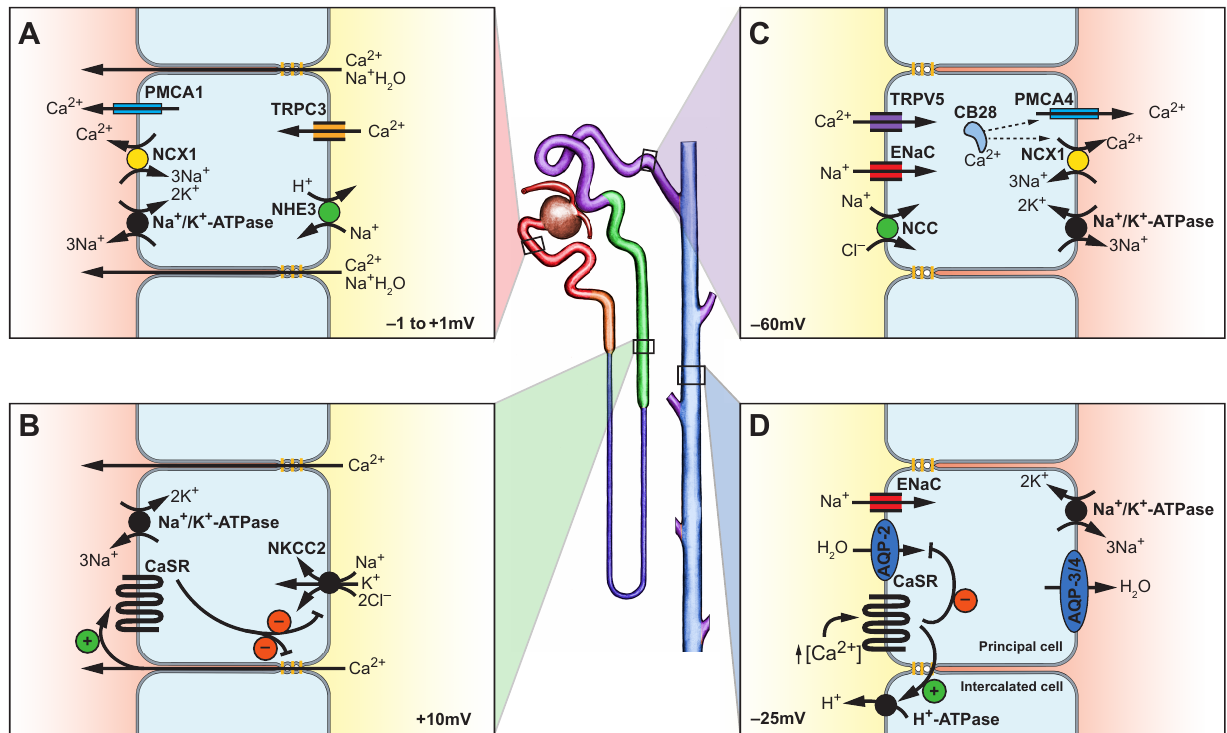
Figure 2. A schematic drawing of the renal tubular system. The glomerulus (brown) produces a primary urine that flows into the proximal convoluted tubule (red). Then, it reaches the proximal straight tubule before ending up in the loop of Henle, which is composed of a thin (dark blue) and a thick (green) part. The latter drains the urine into the distal convoluted tubule (purple) before reaching the collecting duct (light blue) via the connecting tubule, which is not specifically displayed here [24]. The magnifications detailed in ( A – D ) reveal physiological mechanisms of the tubular Ca